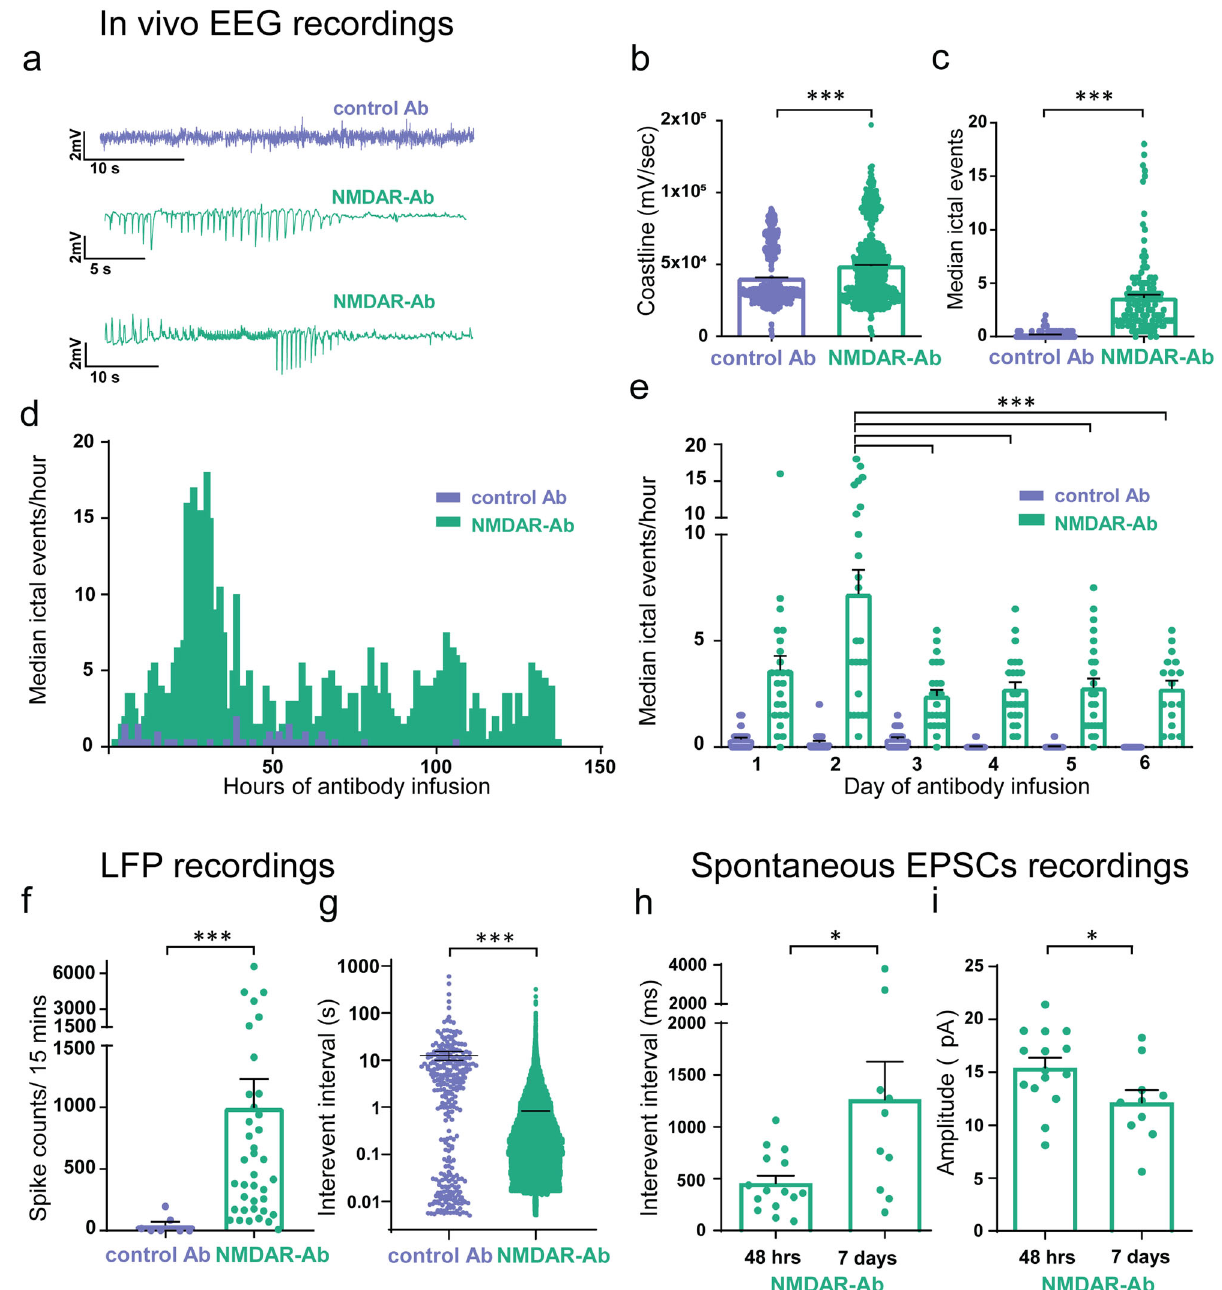
Fig. 3 In vivo spontaneous epileptic EEG activity recorded in rodents infused with NMDAR antibodies. a Example EEG recordings from experimental rodents using wireless EEG transmitters with osmotic pumps in situ delivering control or NMDAR antibodies. b EEG coastline length (calculated per second for the total 7 day recording period for each animal) in NMDAR antibody animals as compared to control animals ( n = 6 animals in each group; *** p < 0.0001, Mann – Whitney). c The number of spontaneous ictal events/hour (mean median± SEM) in the NMDAR antibody animals compared to controls (*** p < 0.001; Mann – Whitney). d Graph illustrating median number of ictal events over time of control and NMDAR antibody infusion . e Daily comparison of ictal events in the NMDAR antibody and control antibody animals (*** p = <0.001, two-way Anova with Bonferroni correction). f Ictal spike counts from hippocampal LFP measurements in brain slices prepared from NMDAR antibody and control antibody infused animals at the end of the in vivo EEG recording period (controls ( n = 7) vs. NMDA ( n = 38); *** p < 0.001, Mann – Whitney. g Interevent interval from hippocampal LFP measurements in brain slices prepared from NMDAR antibody and control antibody infused animals at the end of the in vivo EEG recording period (controls ( n = 7 brain slices) (12.56 ± 2.70) vs. NMDA ( n = 38 brain slices); *** p < 0.001; Mann – Whitney). h Interevent interval of sEPSCs recorded from putative CA3 cells in slices prepared from animals after 7 days of NMDAR antibody ( n = 15 cells) as compared to the same measurements taken at 48 h after NMDAR antibody infusion ( n = 18 cells) (* p = 0.03; Mann – Whitney). i Amplitude measurements of sEPSCs recorded from putative CA3 cells in slices prepared from animals after 7 days of NMDAR antibody ( n = 15 cells) as compared to the same measurements taken at 48 h after NMDAR antibody infusion ( n = 18 cells) (* p = 0.03; Mann – Whitney). Measurements expressed as mean (M) ± standard error of the mean